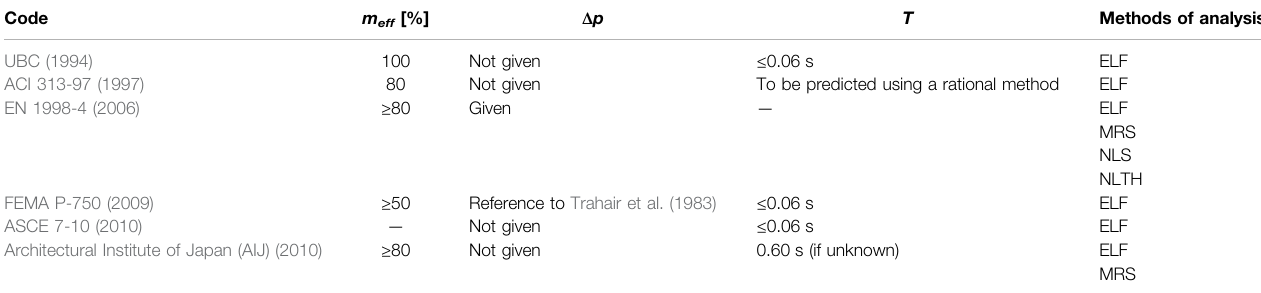
TABLE 1 | Summary of the provisions in current standards.